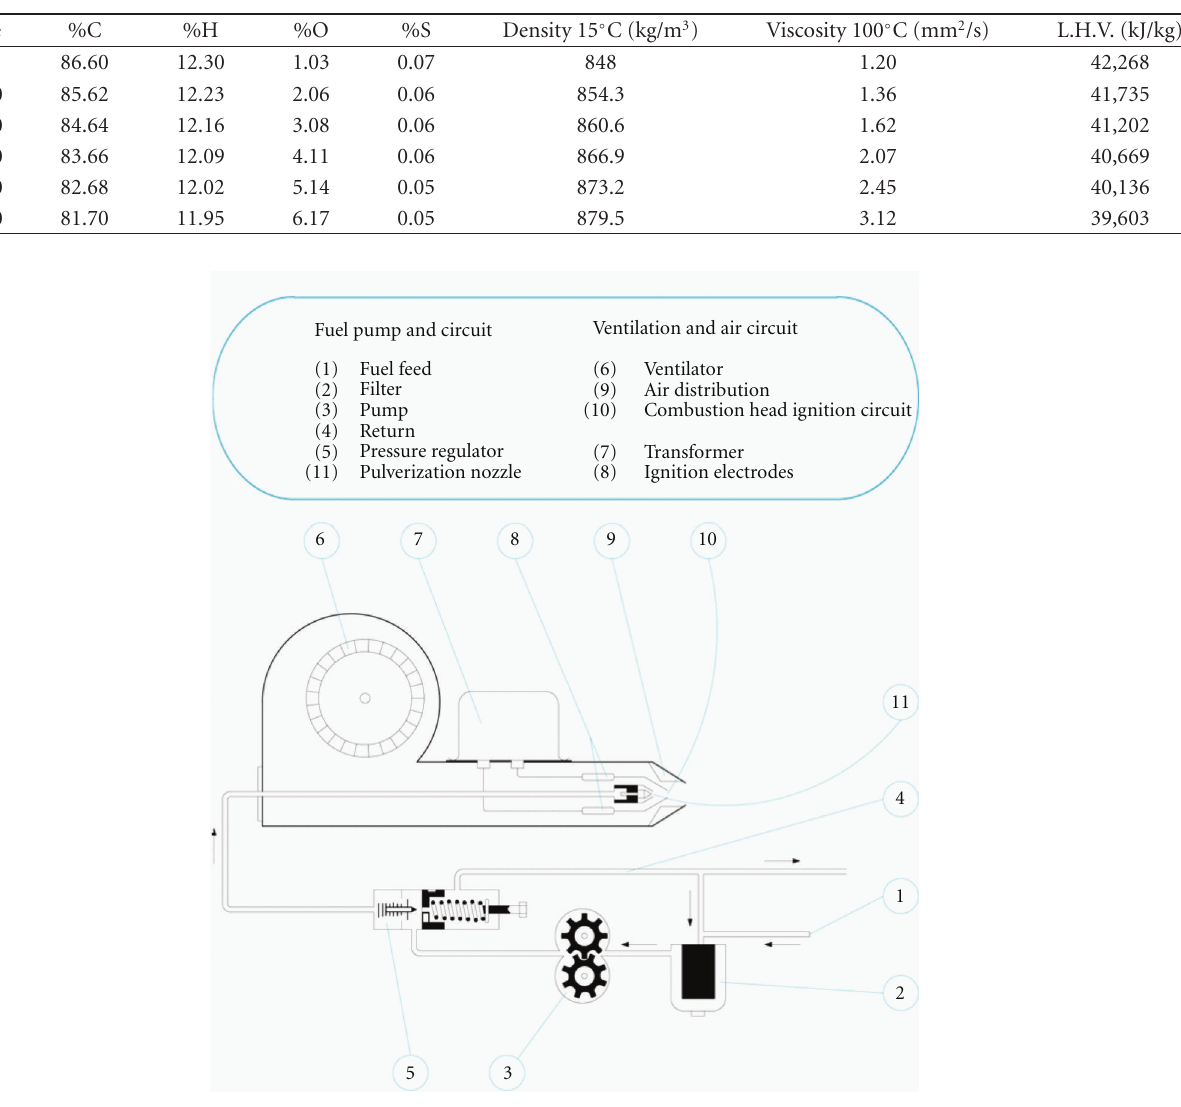
Figure 3: Operating diagram of a pressure atomization